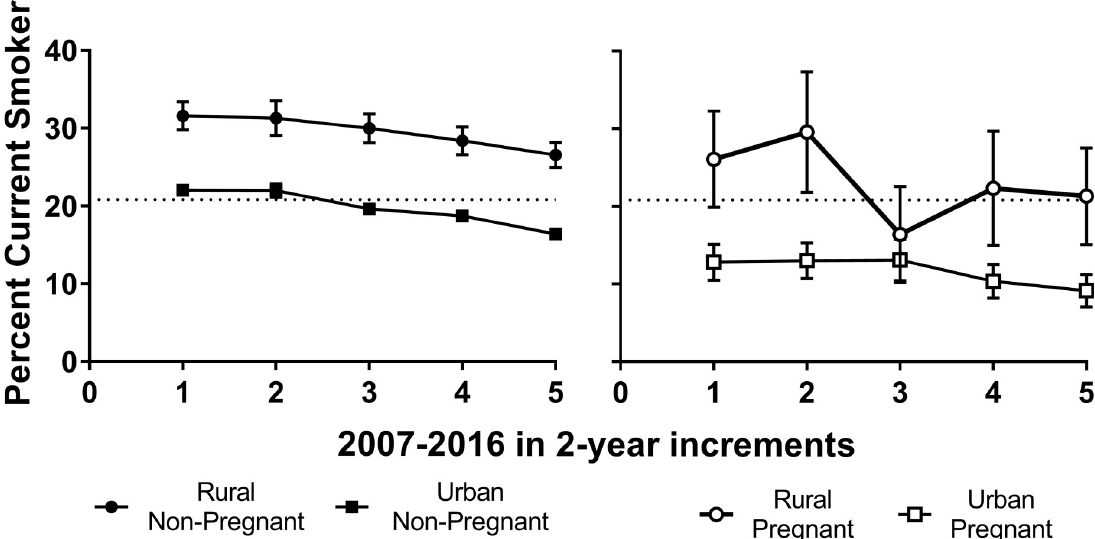
Fig 2. Current cigarette smoking prevalence among rural versus urban women, separated by pregnancy status, in 2-year increments with 95% confidence bars. Estimates are weighted to reflect the U.S. population during the years 2007–2016.